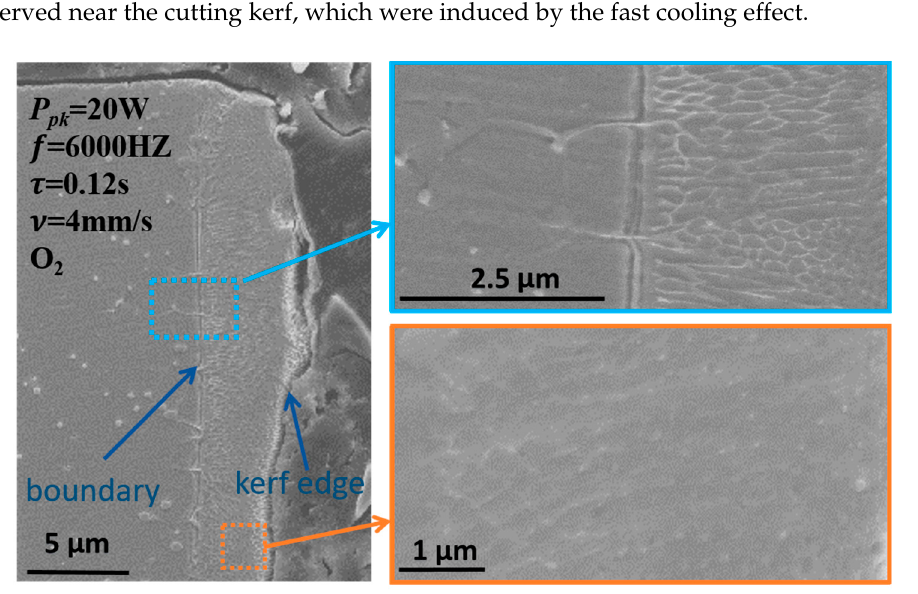
Figure 11. The microstructure of cutting kerfs with metallographic preparation.